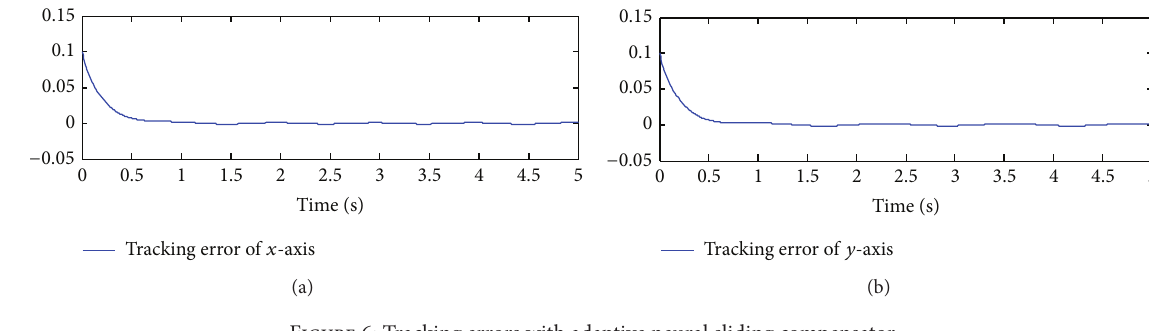
Figure 6: Tracking errors with adaptive neural sliding